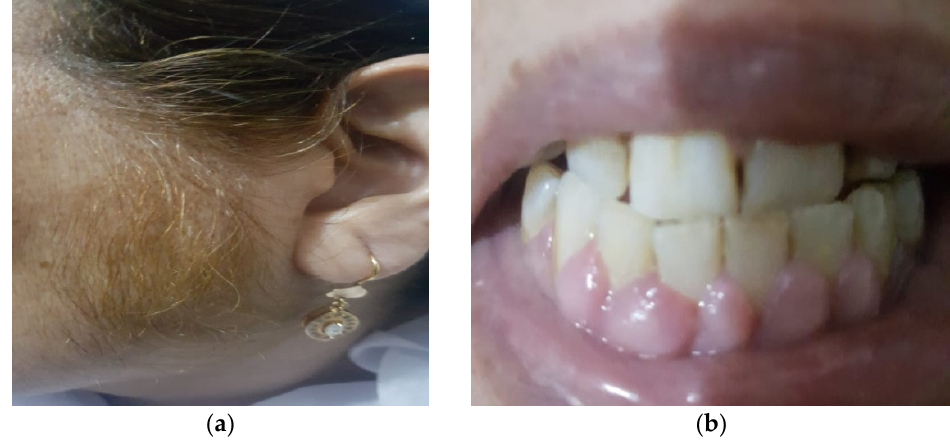
Figure 1. Two prominent ADRs in subject of case report: ( a ) CsA-induced hypertrichosis with thick facial hairs; ( b ) CsA-induced gingival hyperplasia.